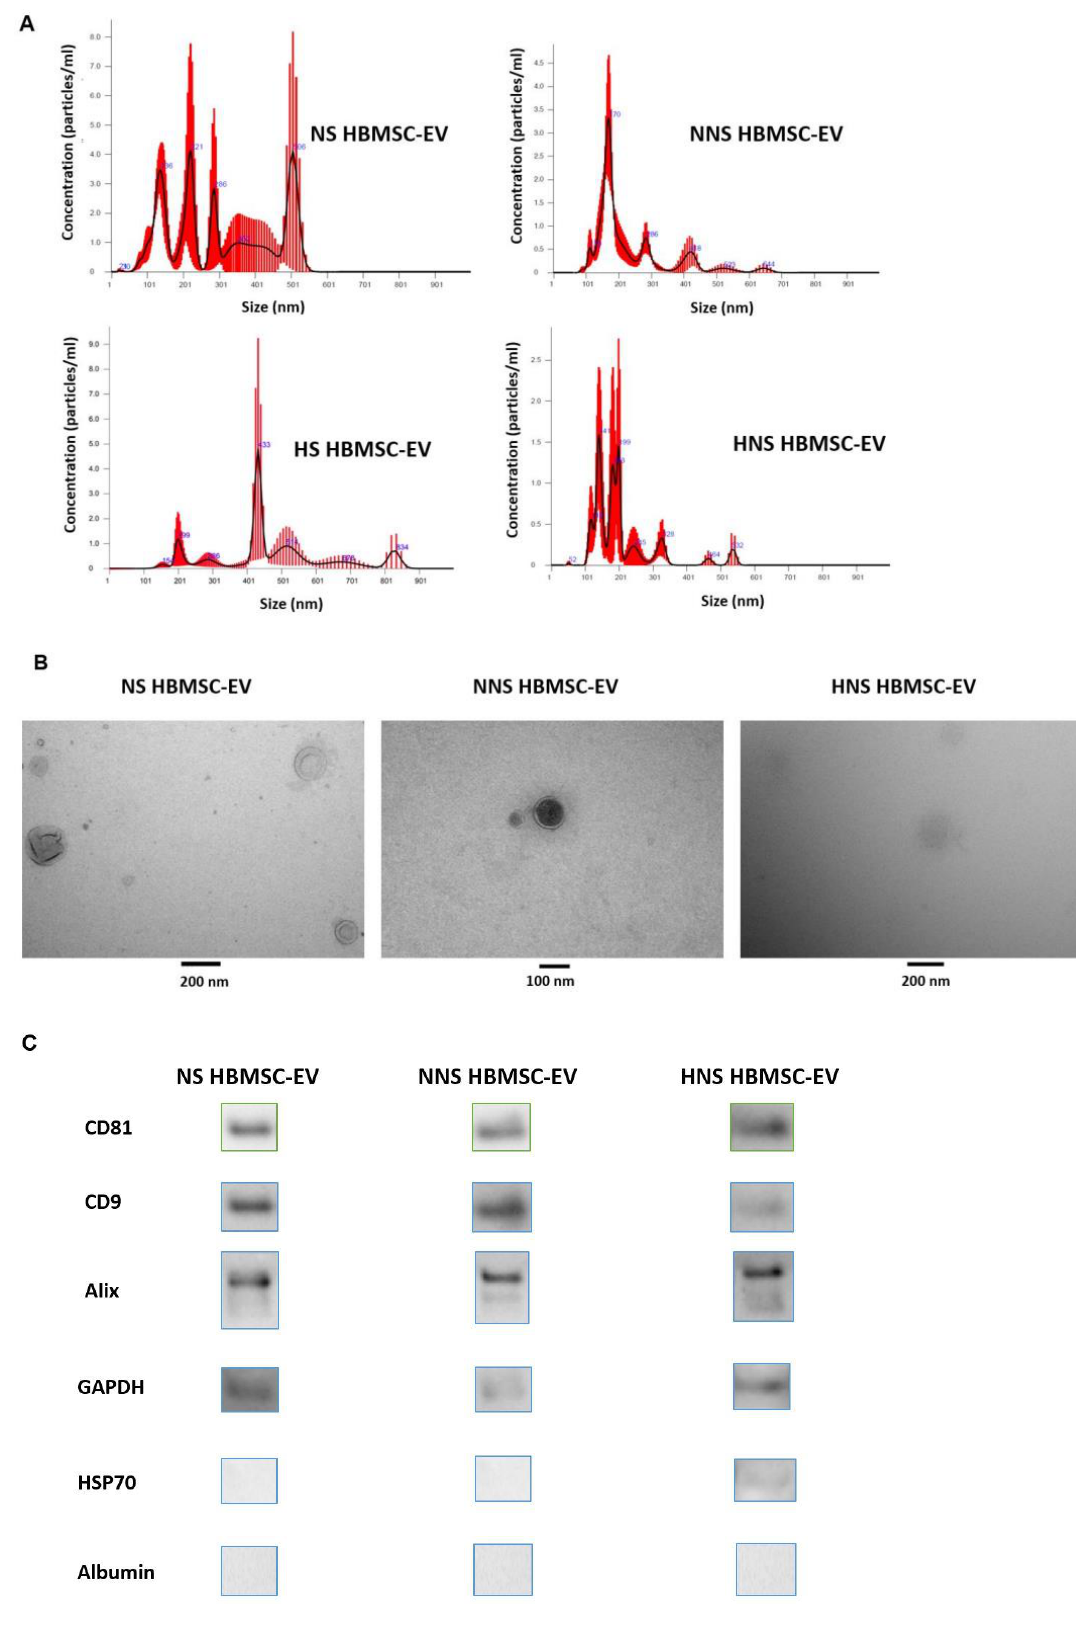
Figure 1. NS, NNS, HS, and HNS HBMSC-EV Characterization. Characterization was done with ( A ) NTA, ( B ) electron microscopy, and ( C ) Western blot. CD81, CD9, Alix, and GAPDH were identified in the NS, NNS, and HNS HBMSC-EV types. HSP70 was only identified in HNS HBMSC-EV. Albu- min was not identified in any of the HBMSC-EV types, the absence of which is a marker of sample purity. Western blot was used to only qualitatively identify the presence of known HBMSC-EV markers and no statistical analysis or comparisons were performed between HBMSC-EV types. Western blot bands are displayed separately, given the need for wide-ranging exposure times. Given the extremely low protein content of HS HBMSC-EV, electron microscopy and Western blot characterization were not able to detect this HBMSC-EV. Each experiment was performed in tripli- cates using three independently isolated EV samples (n = 3).